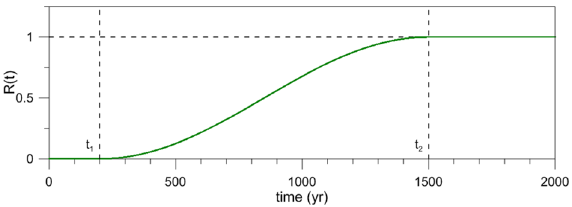
Figure 1. Definition of the ramp function R τ ( t ) ; its duration is defined as τ = t 2 − t 1